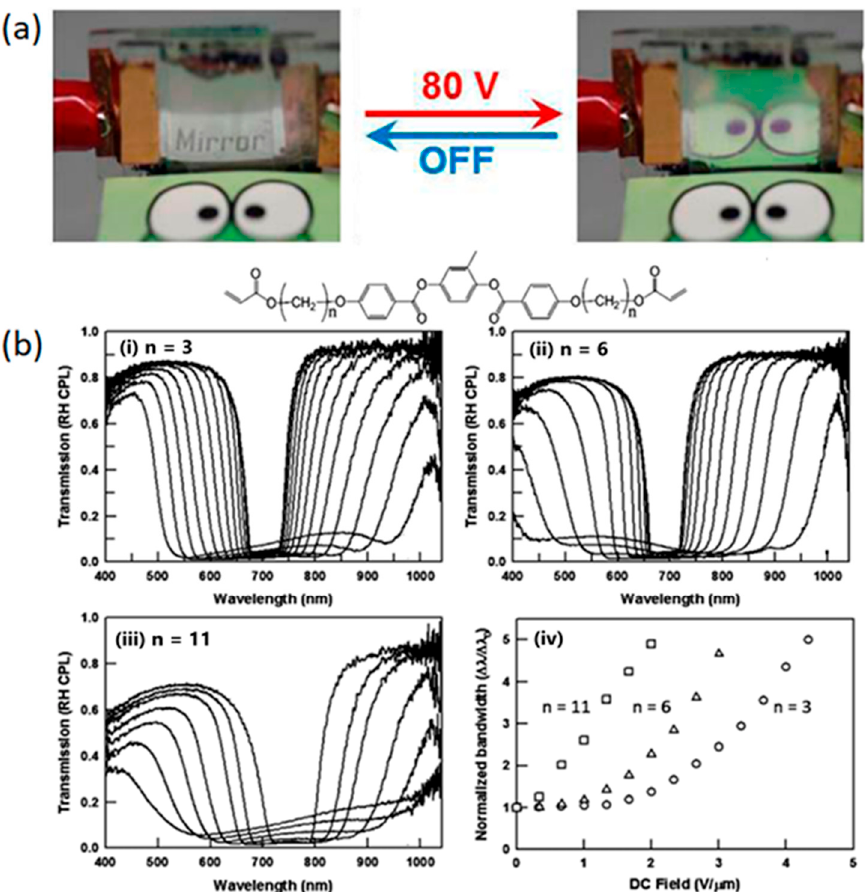
Figure 1. ( a ) Photographs illustrating the transmission and reflection of PSCLC with a thickness of 15 µm at 0 V (left) and 80 V (right). ( b ) Transmission spectra of PSCLC from (i) C3M (n = 3), (ii) C6M (n = 6), (iii) C11M (n = 11) before and during application of DC voltages, and (iv) a summary of the bandwidth change as a function of the DC field. Adapted from ref.